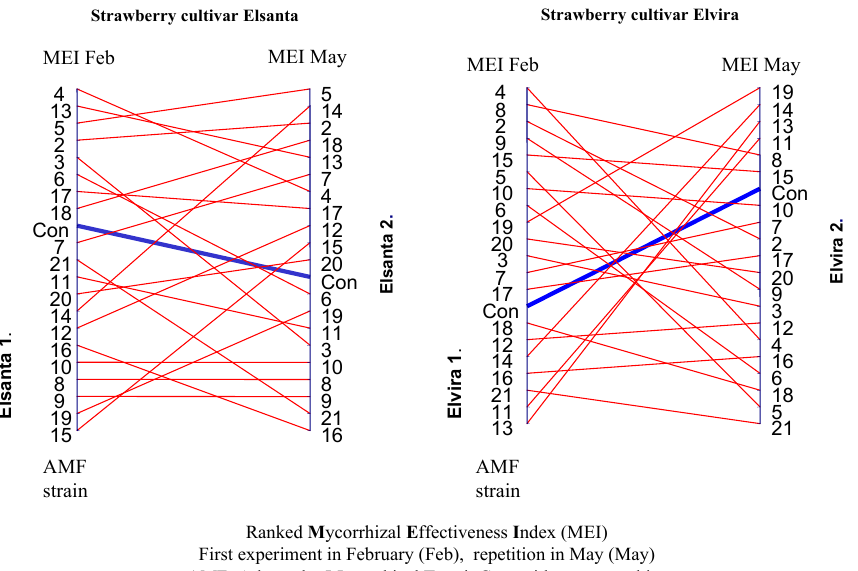
ment interrelationships are relevant for the quantitative outcome of the symbiosis. From a quantitative genetical point of view the quan- titative outcome of the symbiosis, the effectiveness, reflects the phe - notype of the mycorrhizal symbiosis. The results of b aLtruschat (1993) indicated that there was a phenotypic plasticity in an inocu- lum with a huge potential to react to changes in the environment. But at this point we did not yet understand which part of the reaction was induced by the plant and which by the fungal partner.